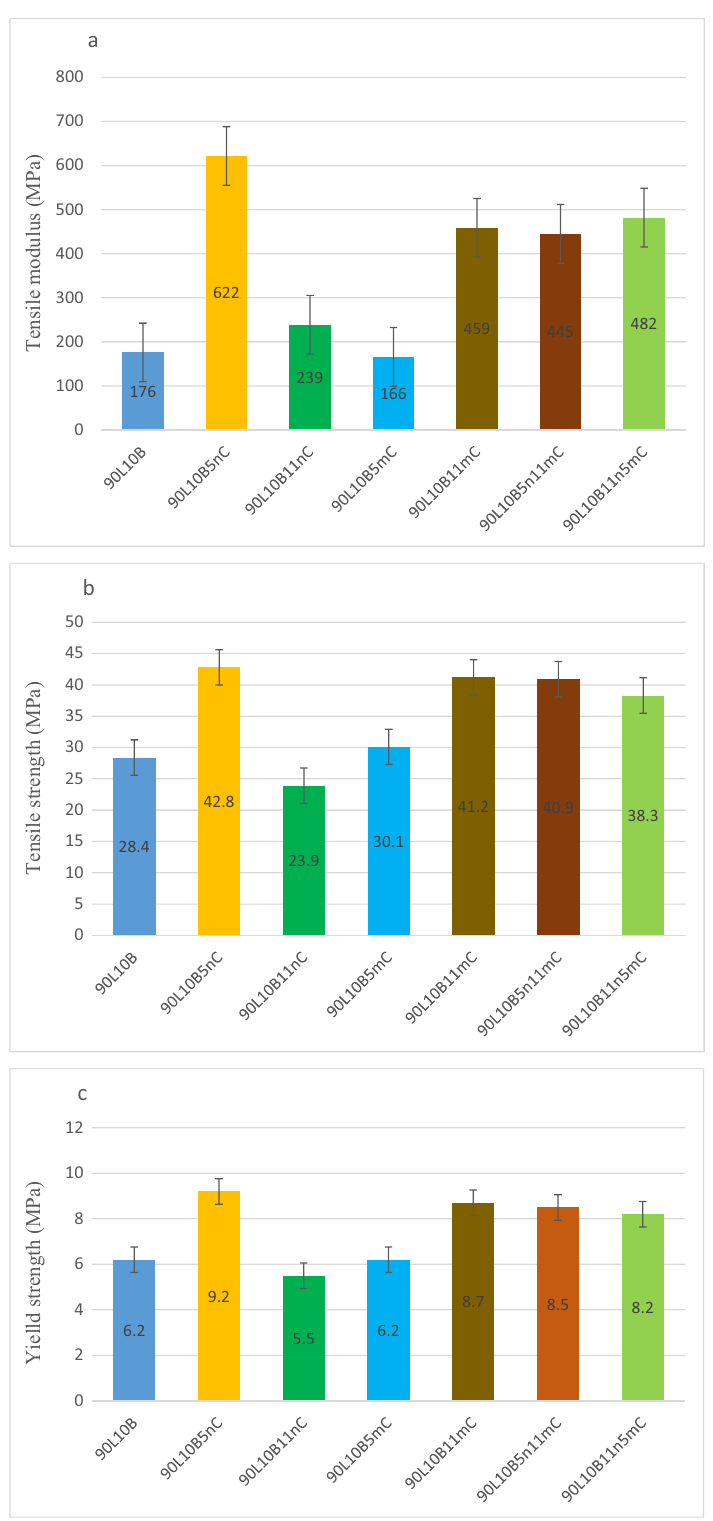
Figure 6: Results of tensile and impact testing of 90 L 10 B and its CaCO 3 composite. ( a ) Tensile modulus, ( b ) tensile strength, ( c ) yield strength, ( d ) elongation at break, ( e ) impact